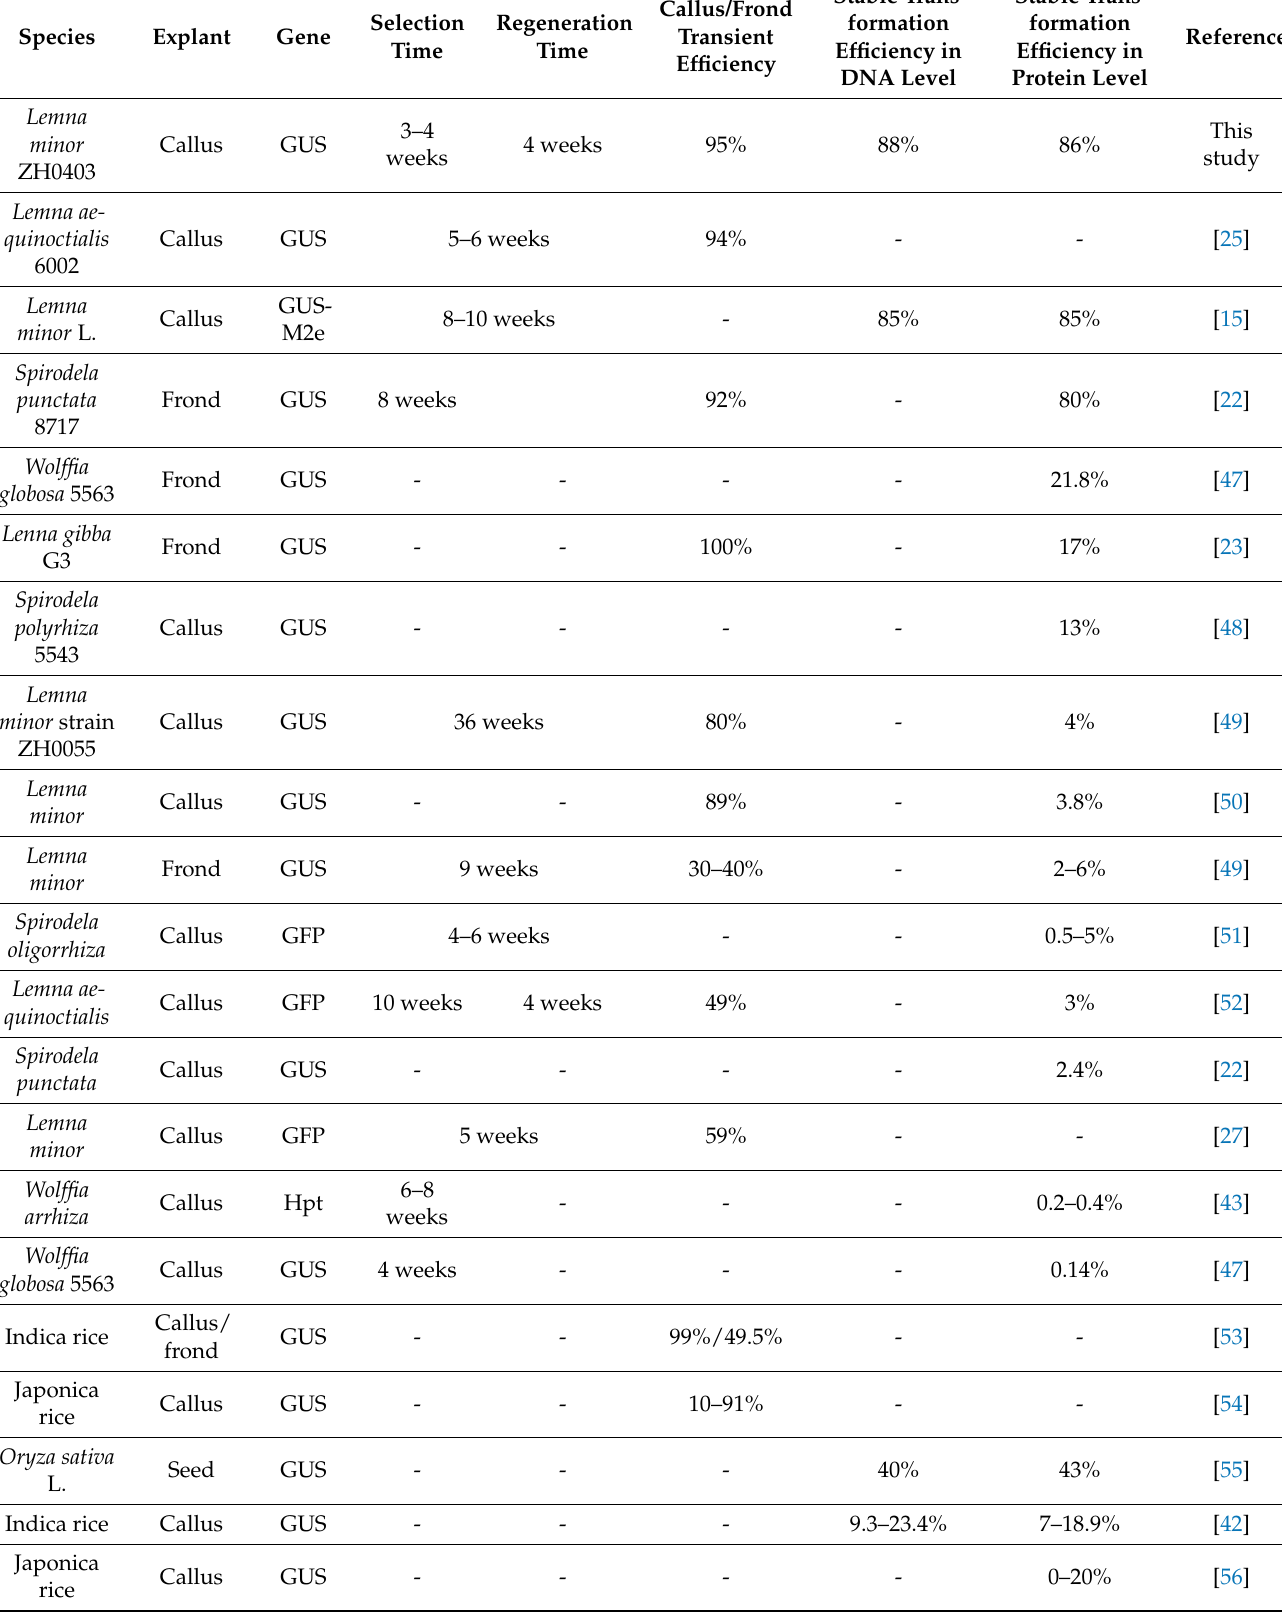
Table 2. Comparison of transformation efficiency among duckweeds and other